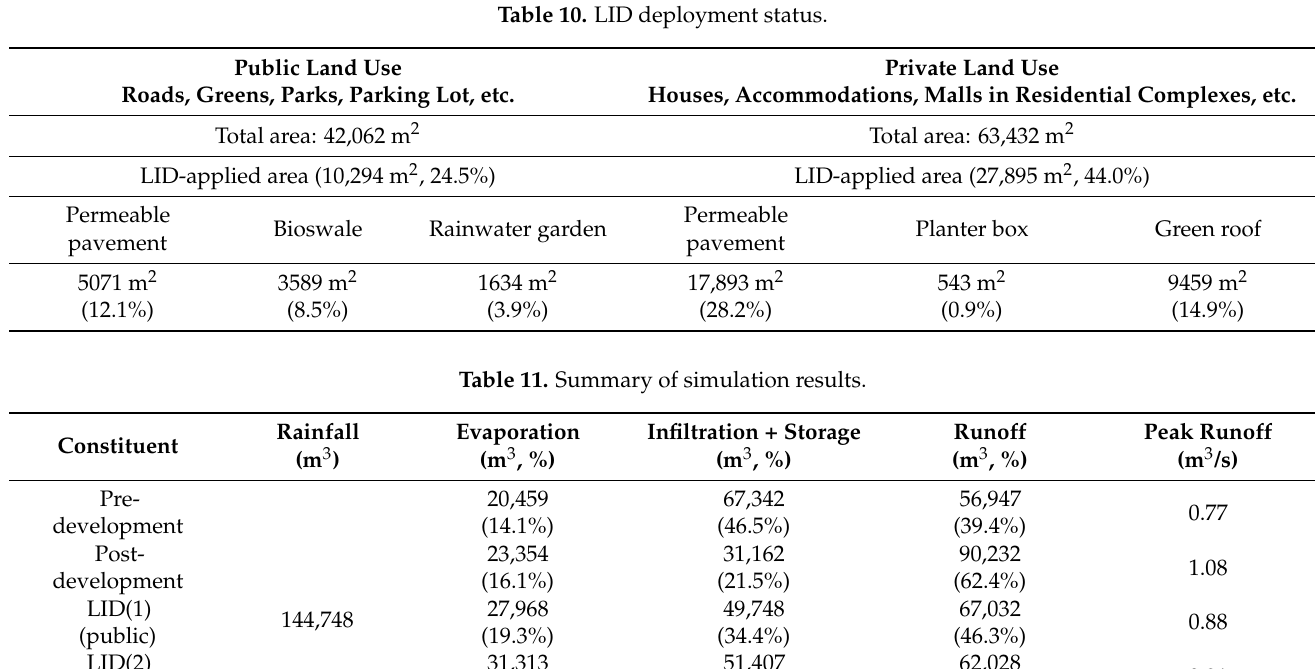
Table 10. LID deployment status.